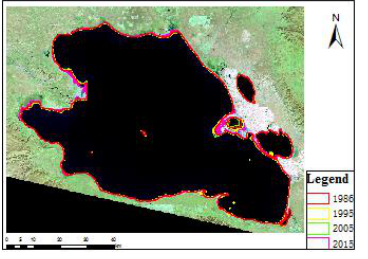
Table 2. Qinghai lake area changes from 1995 to 2015